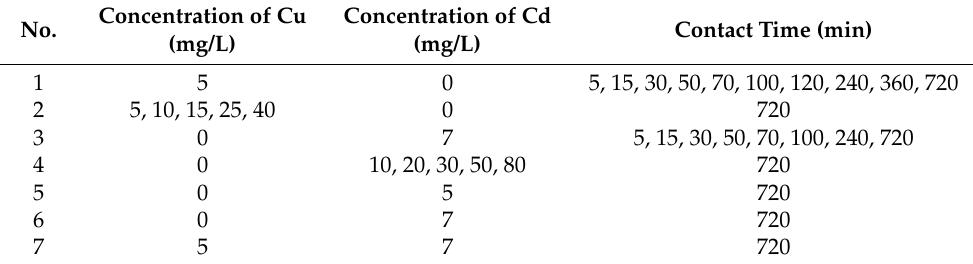
Table 2. Parameter setting of EPS and heavy metal adsorption